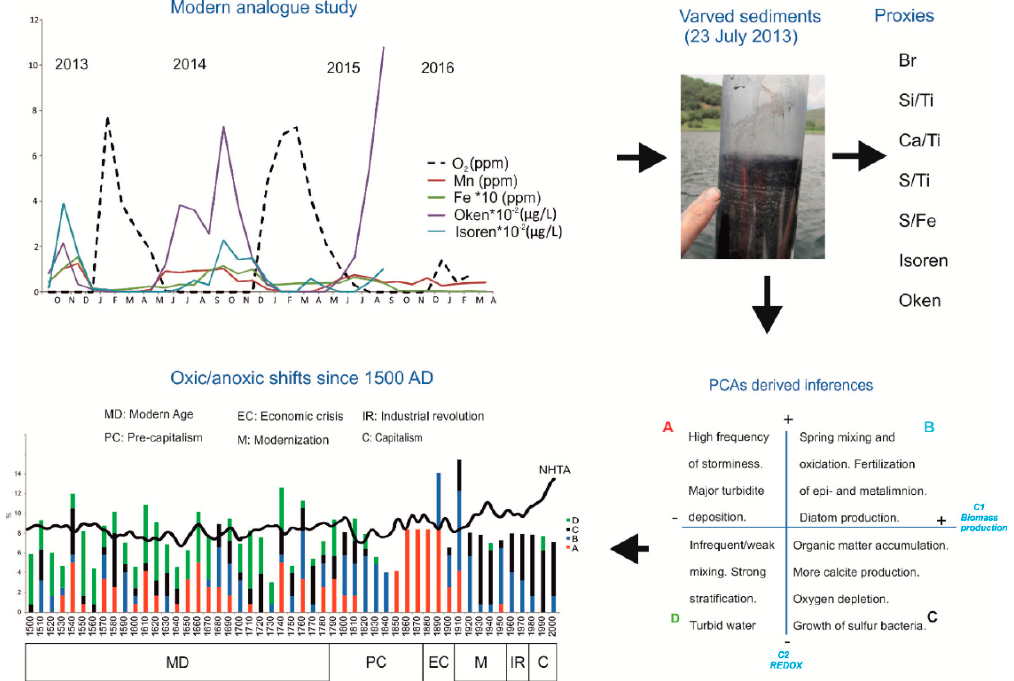
Figure 5. Graphical summary of the modern analogue study about oxygen shifts and inferred results: current seasonal variation of mean values of Fe, Mn, O 2 and phototrophic bacteria pigments okenone (oken) and isorenieratene (isoren) in hypolimnetic waters of Lake Montcortès; varved sediments and proxies obtained; graphic synthesis of inferences derived from Principal Component Analyses; decadal evolution of conditions represented by the subsets A, B, C and D, since CE 1500; bars show the percentage of years that fall within a particular decade. NHTA: Northern Hemisphere temperature anomaly [39]. Redrawn and modified form [20].